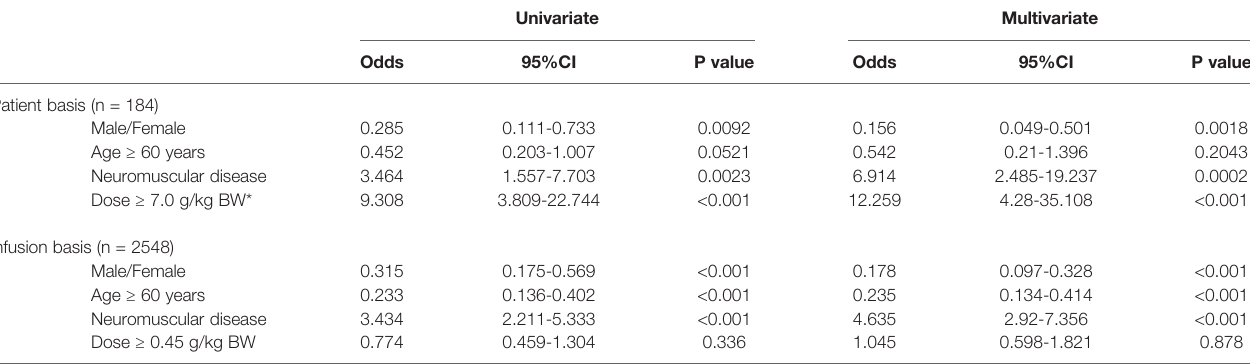
TABLE 5 | Logistic regression analyses of risk factors for adverse reaction to IVIG therapy.